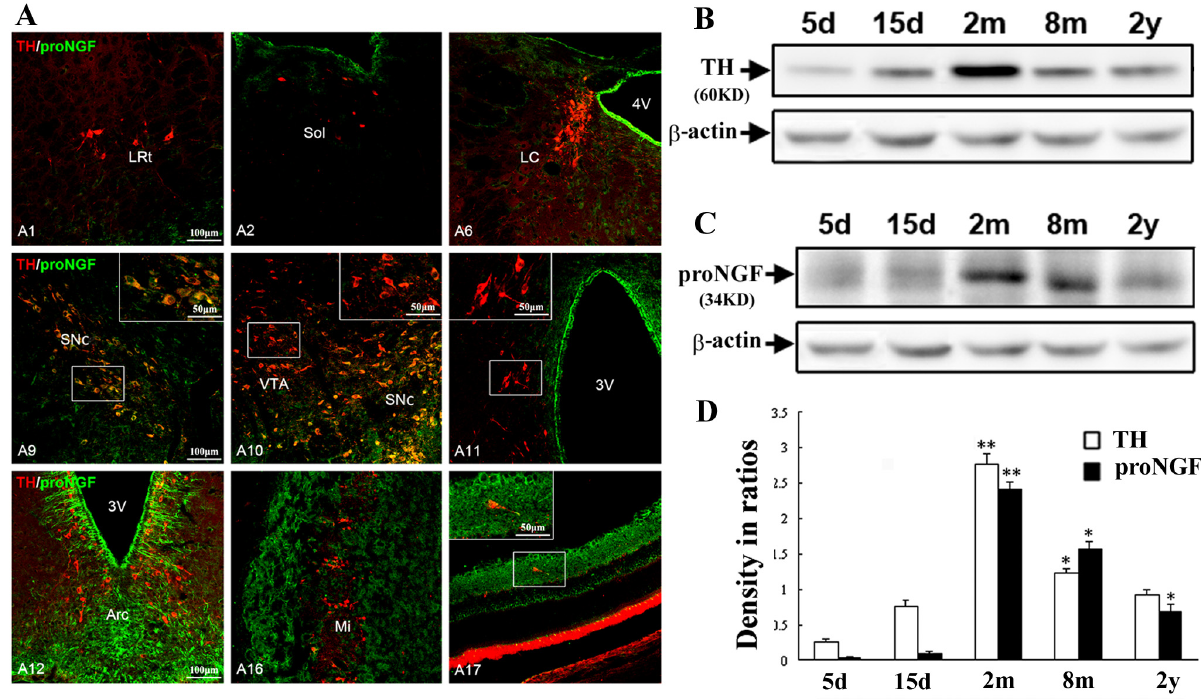
Figure 4. Selective distribution of proNGF/TH neurons and age-related changes in the substantia nigra. ( A ) Distribution patterns of proNGF/TH-positive neurons in all A1–A17 cell groups of whole rat brains. Immunoreactive cells are shown in A1 (lateral reticular area of medulla), A2 (nucleus of solitary tract), A6 (locus coeruleus), A9 (substantia nigra), A10 (ventral tegemental area), A11 (periventricular hypothamic nucleus), A12 (arcuate hypothalamic nucleus), A16 (olfactory bulb) and A17 (retina) areas; ( B ) Immunoblotting of proNGF expression in substantia nigra of postnatal 5 days, 15 days, 2 months, 8 months and 2 years old; ( C ) Immunoblotting of TH expression in substantia nigra of postnatal 5 days, 15 days, 2 months, 8 months and 2 years old; and ( D ) Comparison of proNGF and TH expression levels in the substantia nigra in ratio to internal control β -actin. ANOVA indicates significance, * p < 0.005, ** p < 0.001 vs. earlier time-point of